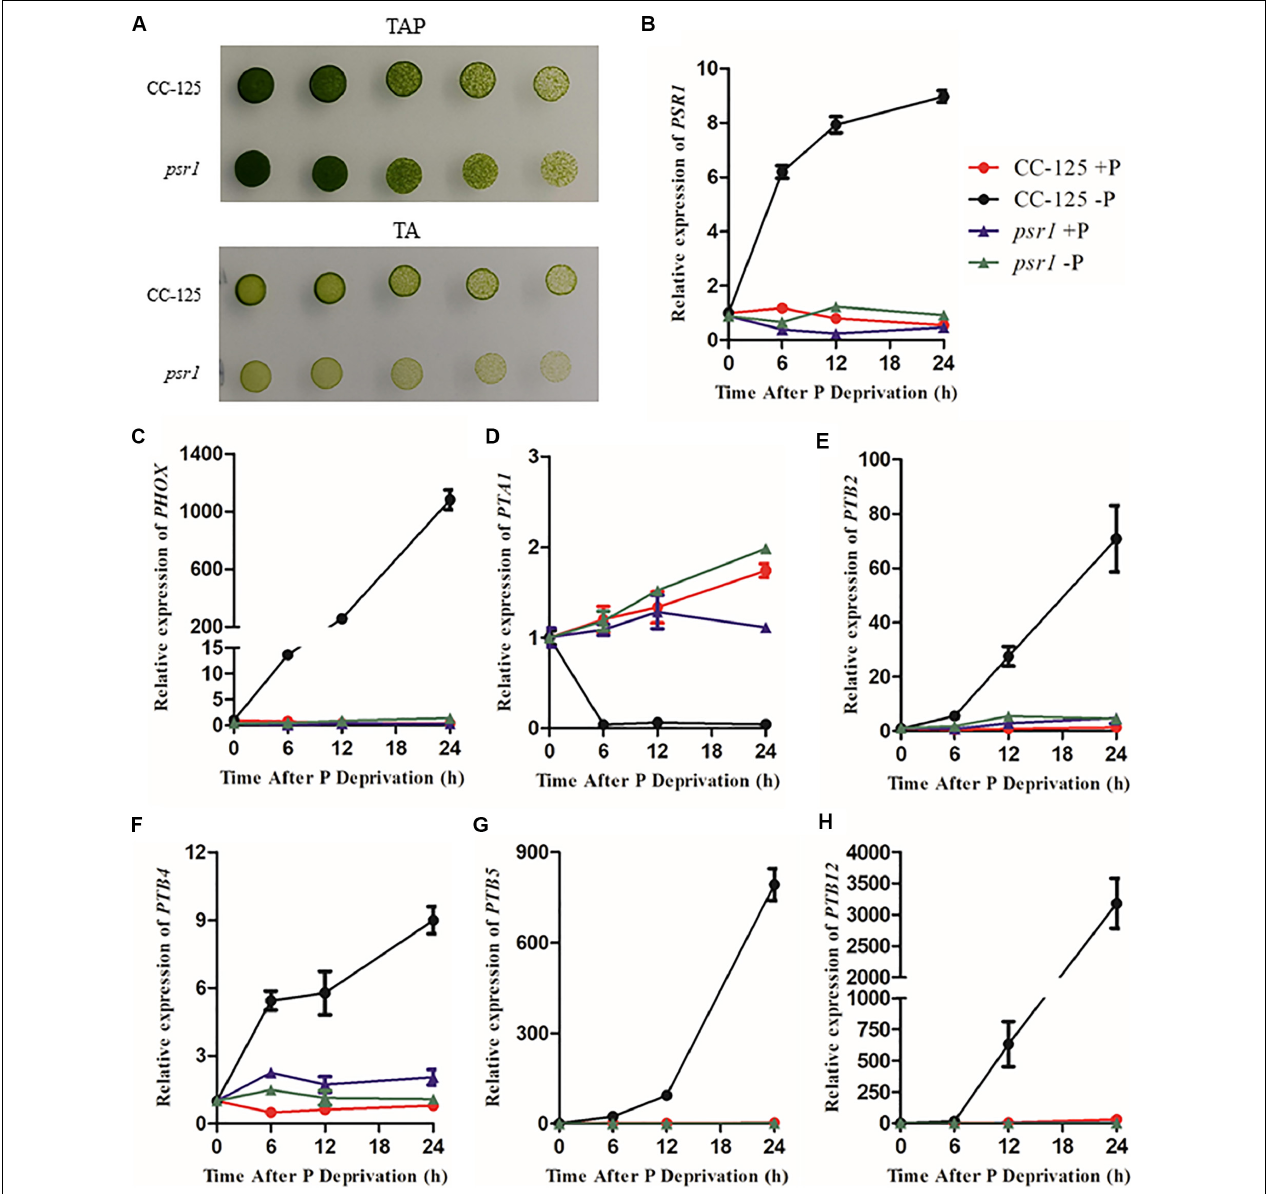
FIGURE 4 | The relative expression of Chlamydomonas PHT genes under phosphate replete and starvation conditions. (A) Growth of CC-125 and psr1 in the TAP or TA plate. (B) to (H) , The CrPSR1 (B) , CrPHOX (C) , CrPTA1 (D) , CrPTB2 (E) , CrPTB4 (F) , CrPTB5 (G) , and CrPTB12 (H) mRNA levels were quantified by qRT-PCR over a period of 0, 6, 12, and 24 h of phosphate deprivation. CBLP was used as the internal control. For B–H , data are the means ± s.d. All experiments were repeated three times, and similar results were